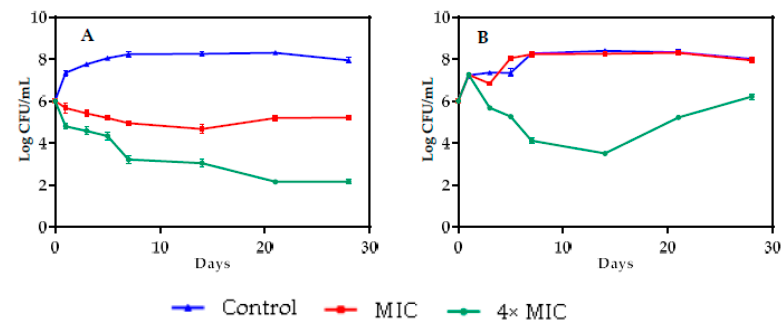
Figure 6. E ff ect of MIC and 4 × MIC of Achillea odorata subsp. pectinata essential oil on Proteus mirabilis Figure 6. Effect of MIC and 4× MIC of Achillea odorata subsp. pectinata essential oil on Proteus mirabilis ( A ) and Bacillus subtilis ( B ) in Barley food ( A ) and Bacillus subtilis ( B ) in Barley food system .